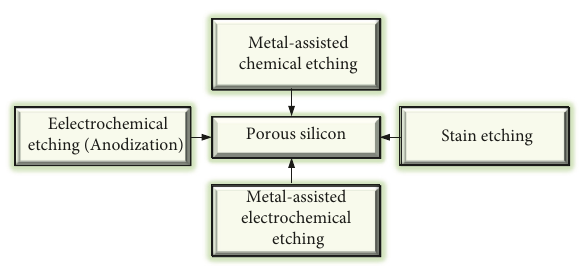
Figure 2: Methods of porous silicon